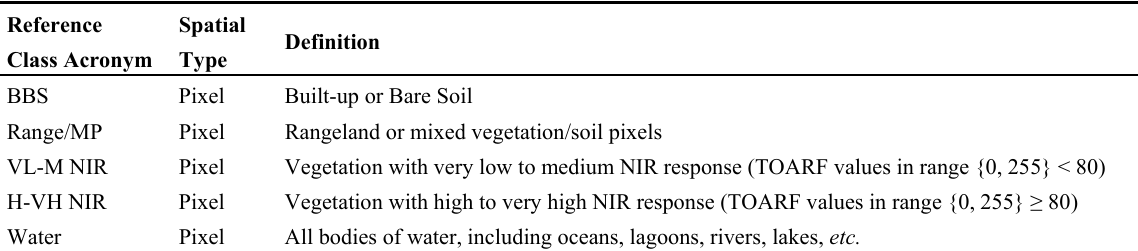
Table 6. Reference class definitions and acronyms for the SPOT-4 HRVIR test image, 20 m resolution, see Figure 2a.